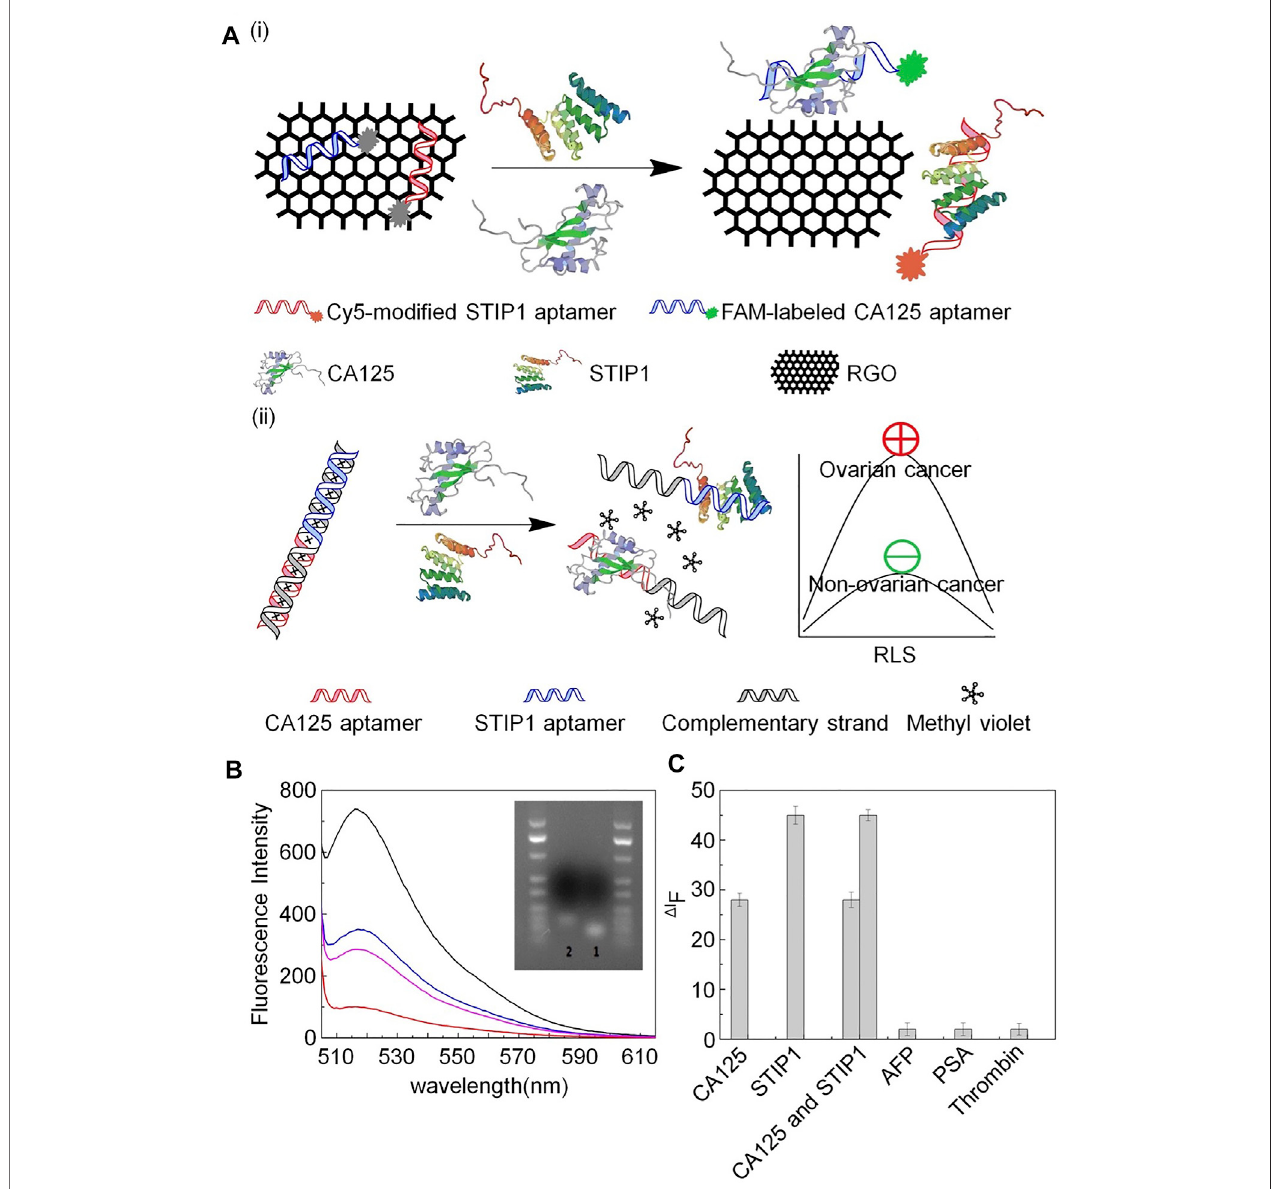
FIGURE 1 | Schematic illustration of aptamer detection of CA125 and STIP1. (A) (i) aptamer-based fl uorescence sensor and (ii) aptamer-based RLS sensor. (B) Fluorescence intensity of FAM-labeled CA125 aptamer. (C) Speci fi c detection of aptamers.